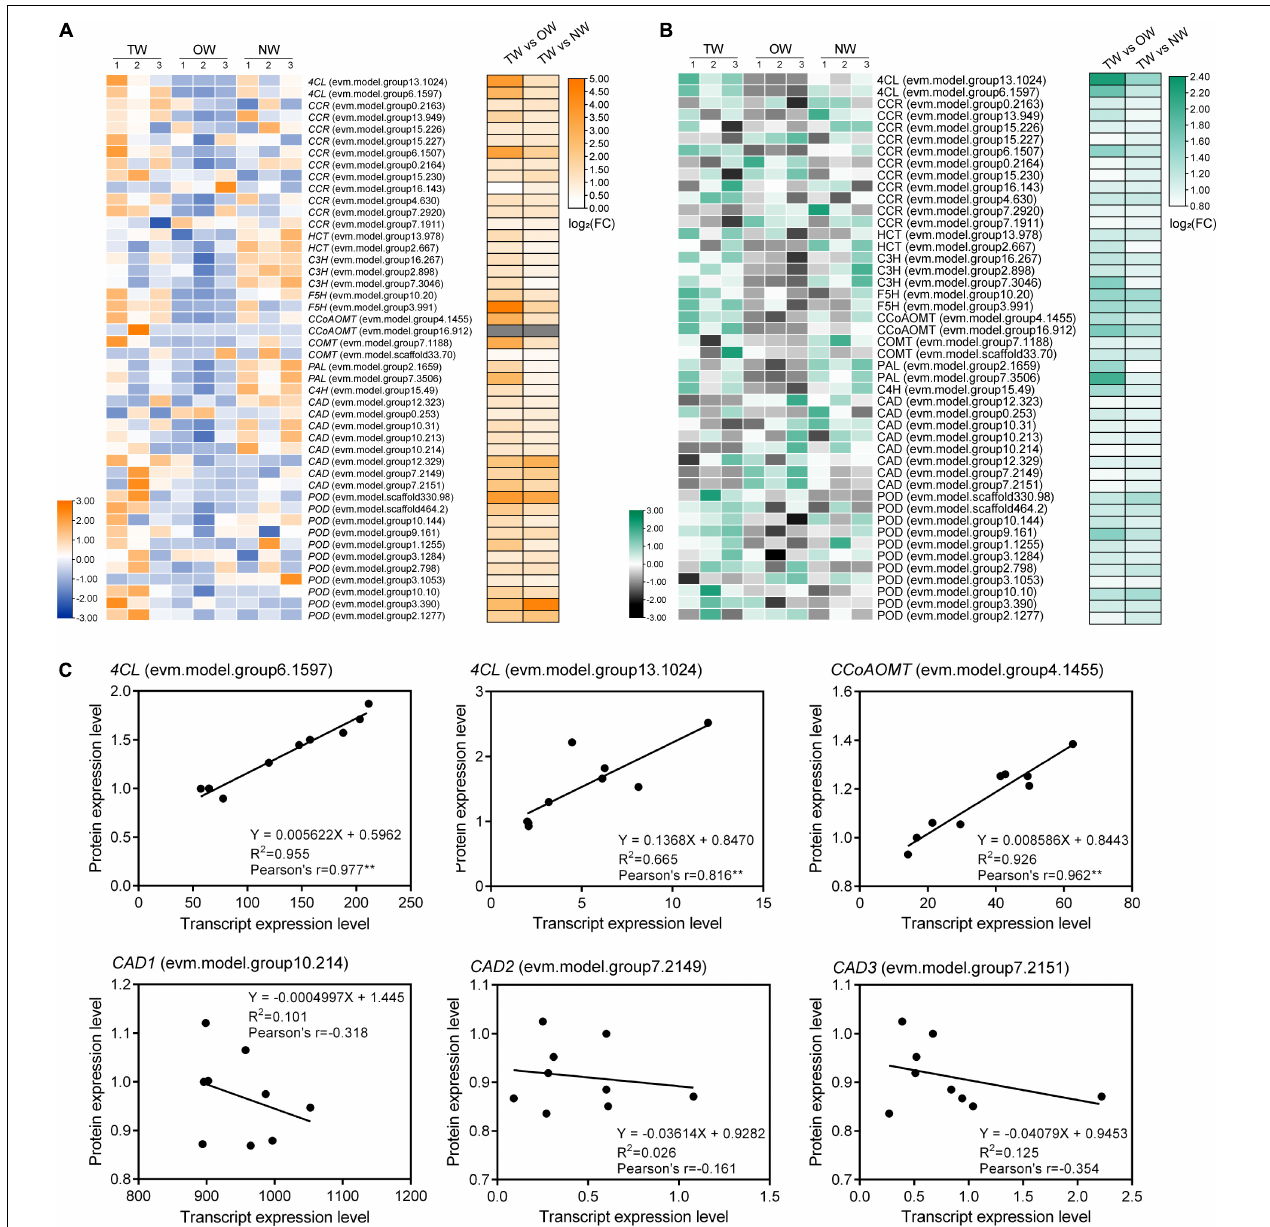
FIGURE 5 | Transcription and translation levels of genes involved in lignin monomer biosynthesis in tension wood (TW), opposite wood (OW), and normal wood (NW). The numbers in panels (A,B) represent the biological replicates. (A) Transcription levels in TW, OW, and NW and differential expression of genes involved in the lignin metabolism pathway between groups, (B) translation levels in TW, OW, and NW and differential expression of genes involved in the lignin metabolism pathway between groups, (C) correlation analysis of the transcription and translation levels of candidate genes. Pearson’s r indicates the Pearson correlation coefficient. ** indicates 1% significance. Gene transcription levels and protein expression levels showed in heatmap were normalized.